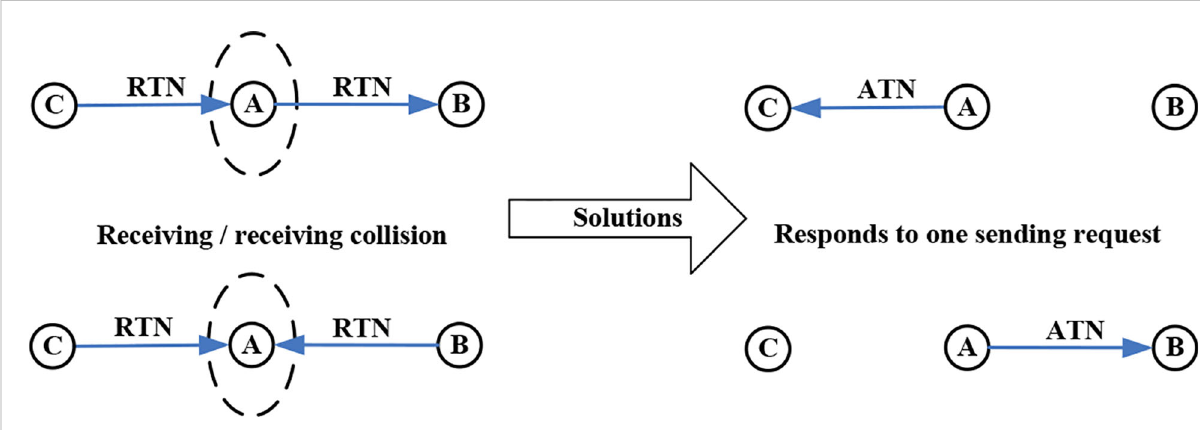
FIGURE 6 Transmission negotiation